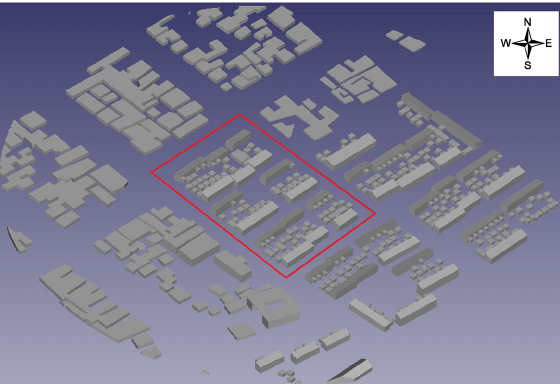
Figure 11. Circular urban area model (red area—the focus urban area) with surroundings at a scale of 1/100 with a radius of 200 m from the midway point.